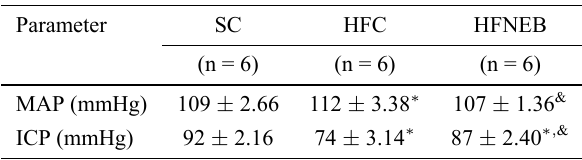
Table 3. Erectile functions.